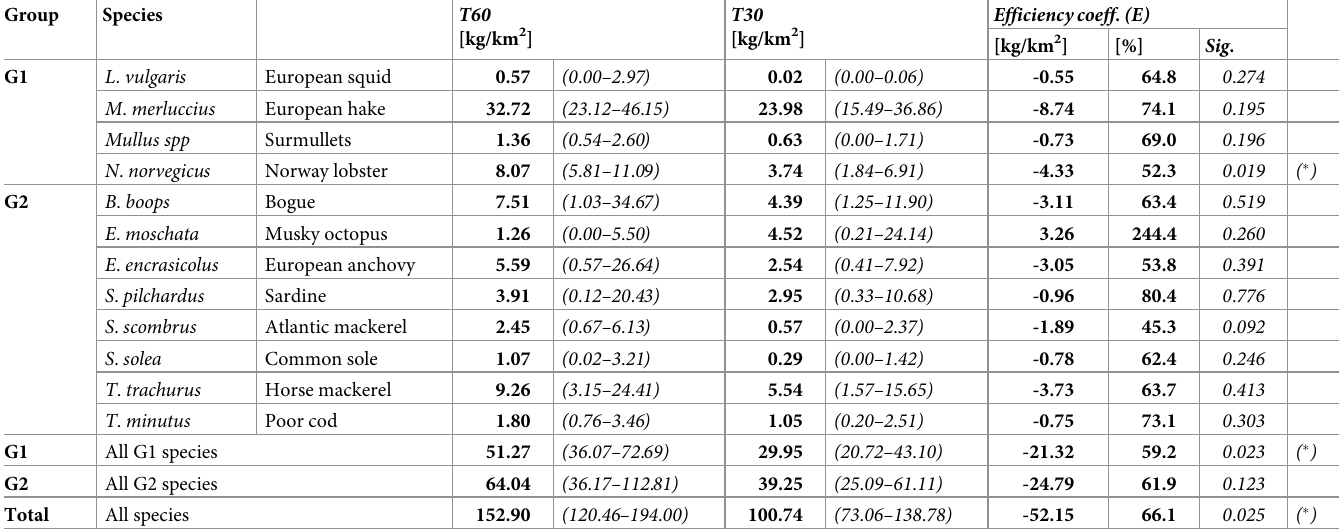
Table 1. Geometric Mean of the CPUE in terms of weight (kg/km 2